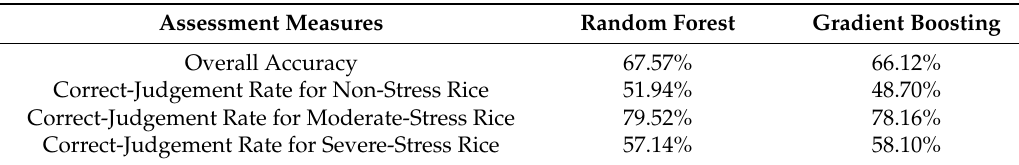
Table 3. Classification accuracy of RF and GB classifiers based on two phenological features.